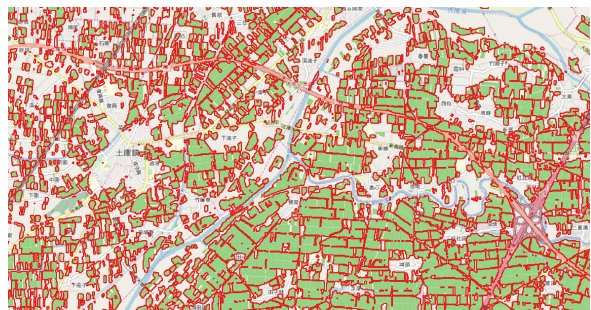
Figure 15. Crop farmland segmentation prediction result.